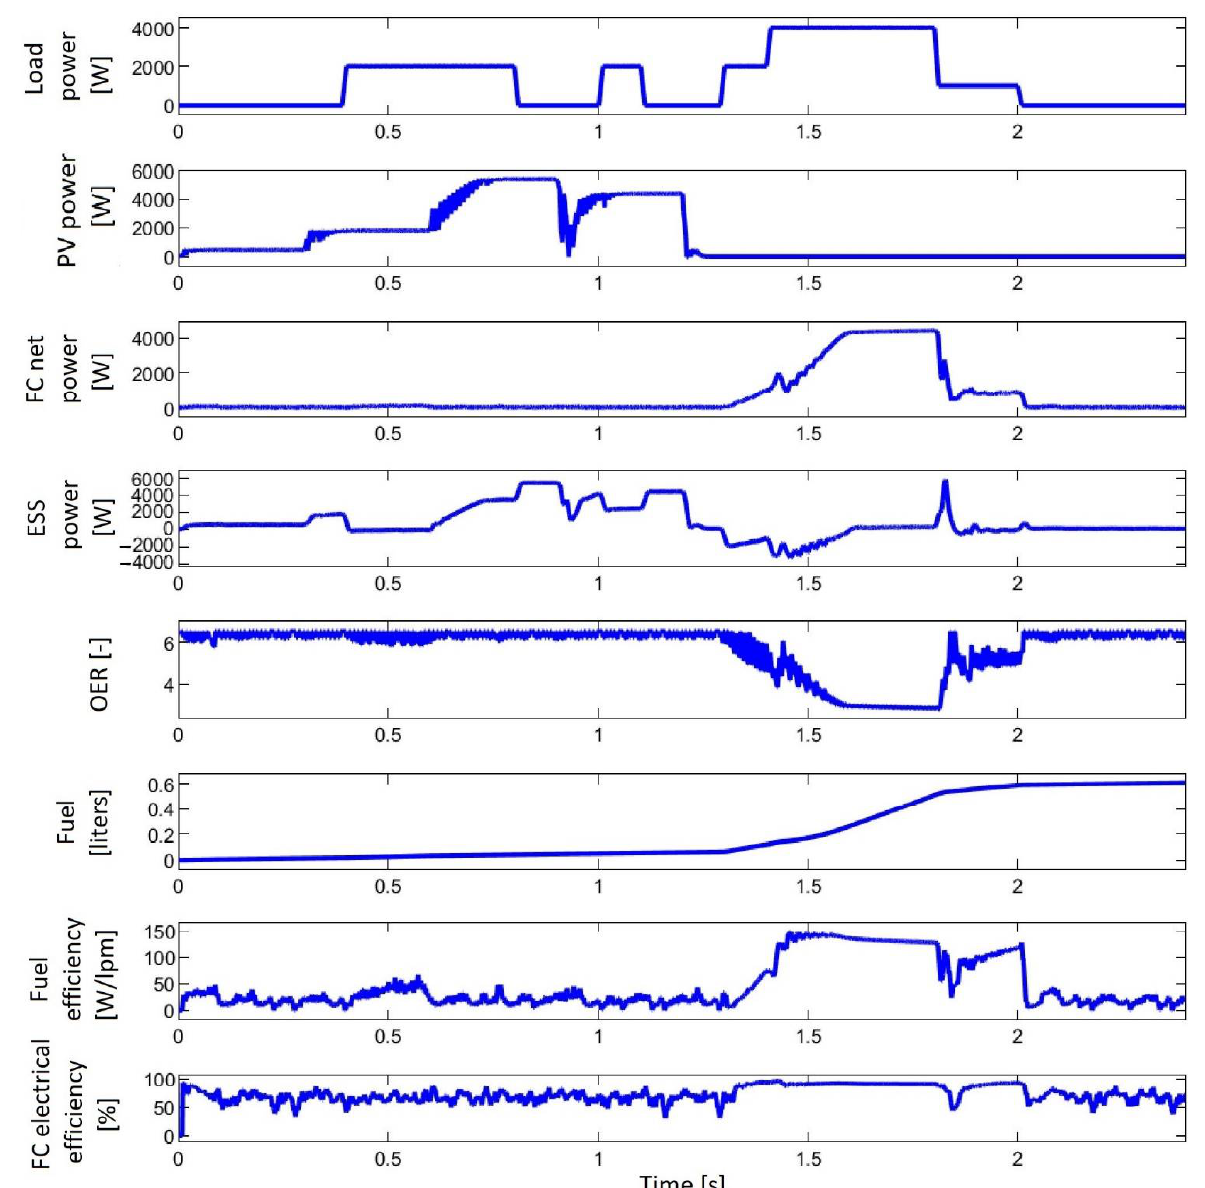
Figure 10. The behavior of the PV/FC/ESS system using strategy S2 in the scenario SC2.